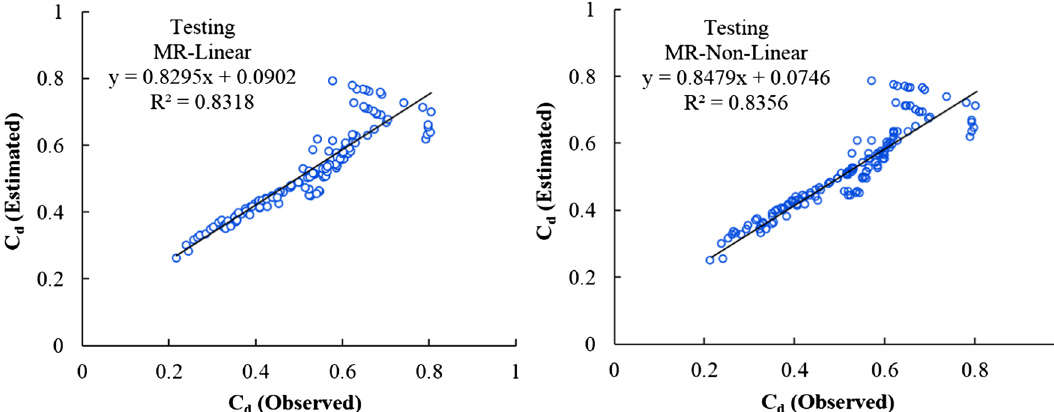
Fig. 6 Distribution diagram of the observational estimated values Table 5 The MR linear and MR nonlinear equation for obtaining the C Equation RMSE D